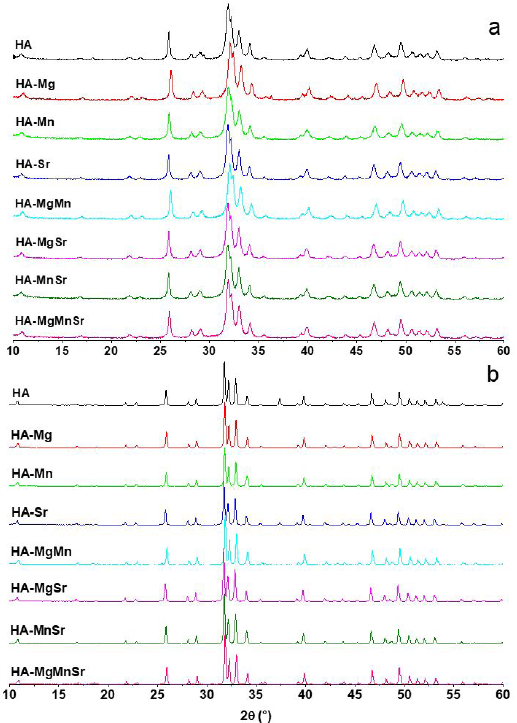
Figure 3. XRD patterns of the a) as-synthesized samples and b) samples after calcination at